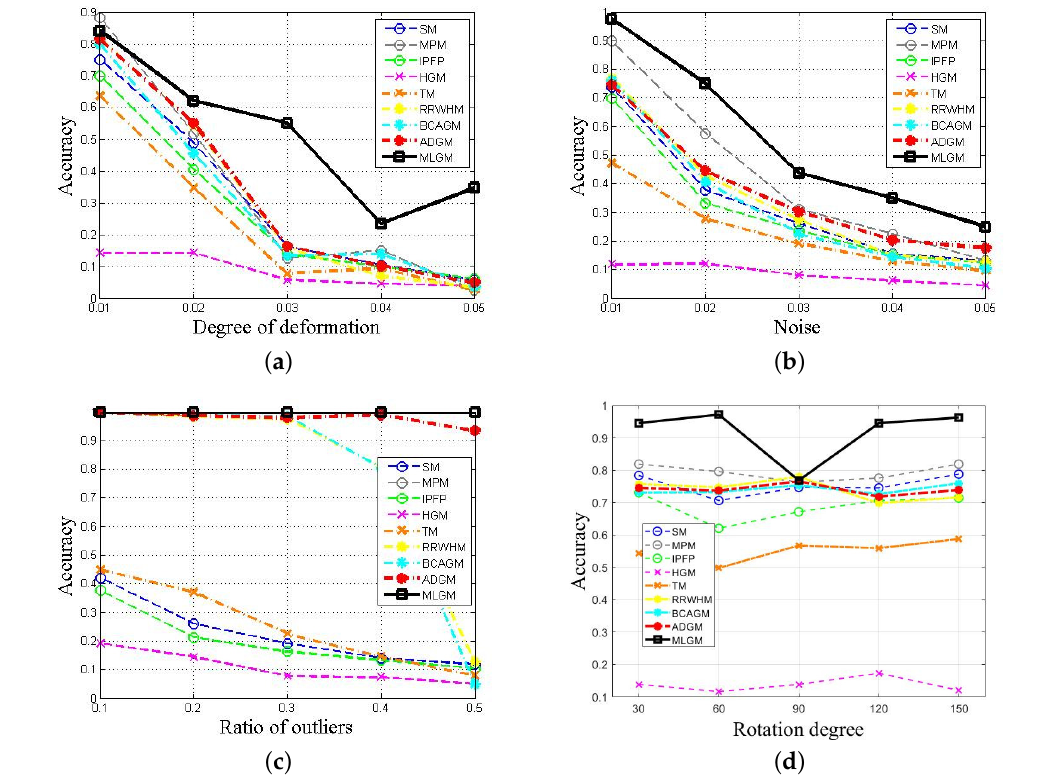
Figure 4. Accuracy comparison on the Fish dataset. ( a ) Accuracy with different degree of deformation. ( b ) Accuracy with different noise level. ( c ) Accuracy with different number of outliers. ( d ) Accuracy with different rotation